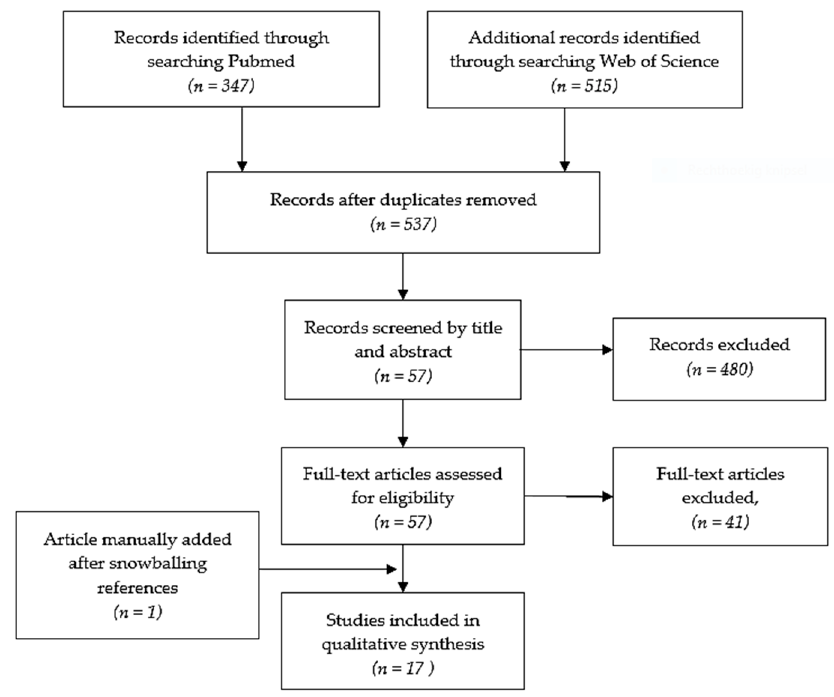
Figure 1. Search strategy Prisma Flow Chart.